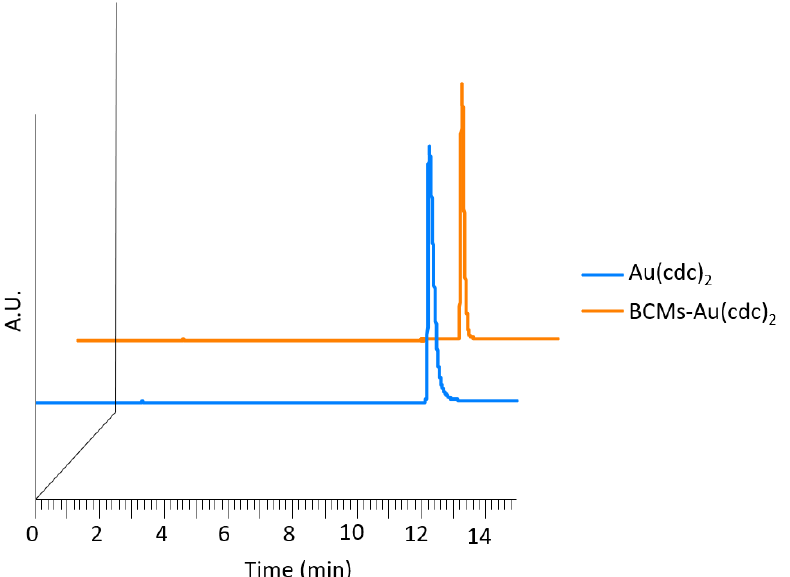
Figure 4. HPLC chromatograms of TBA[Au(cdc) 2 ] (R t = 12.3 min) and gold complexes released from the BCMs-[Au(cdc) 2 ] (R t = 12.3 min) (UV detection at λ = 303 nm). Table 4. Hydrodynamic diameters (d h s), polydispersions (PdIs), and zeta potentials (Z p s) of micelle formulations AS1, AS4, and